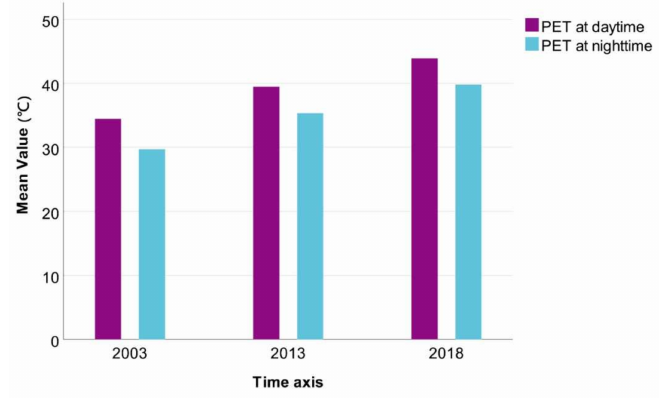
Figure 8. Profile of PET at daytime and nighttime in 2003, 2013, and